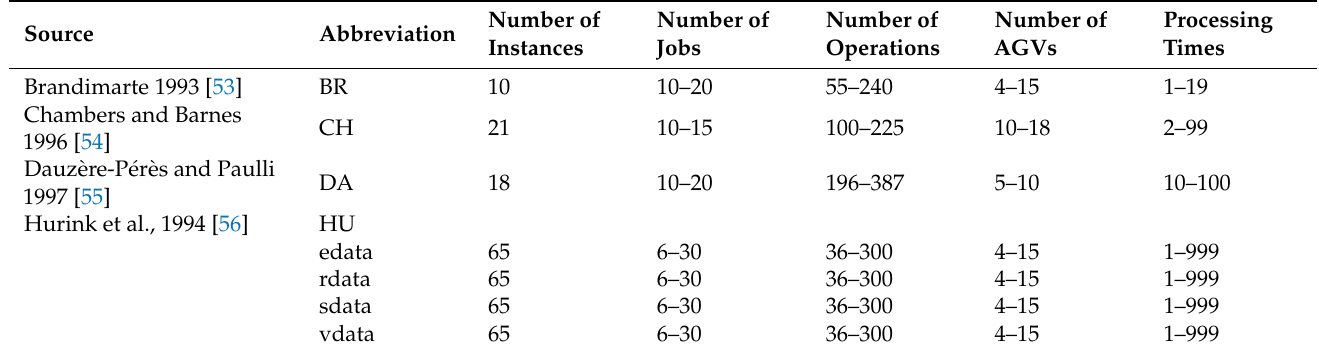
Table 2. Overview of the FJSSP literature benchmark instance collection.